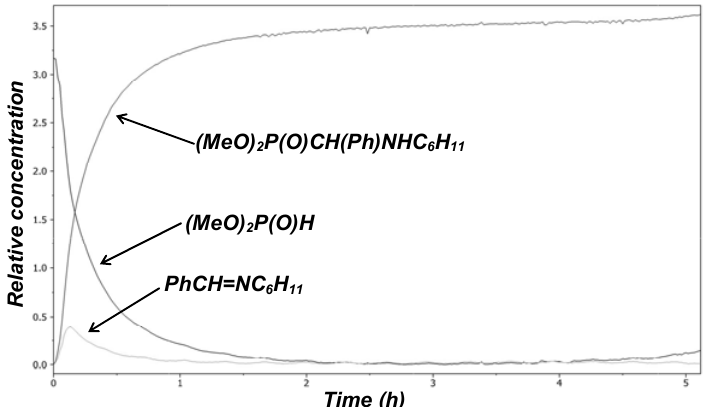
Figure 2. Concentration profile for the Kabachnik–Fields reaction studied at 80 °C in acetonitrile.